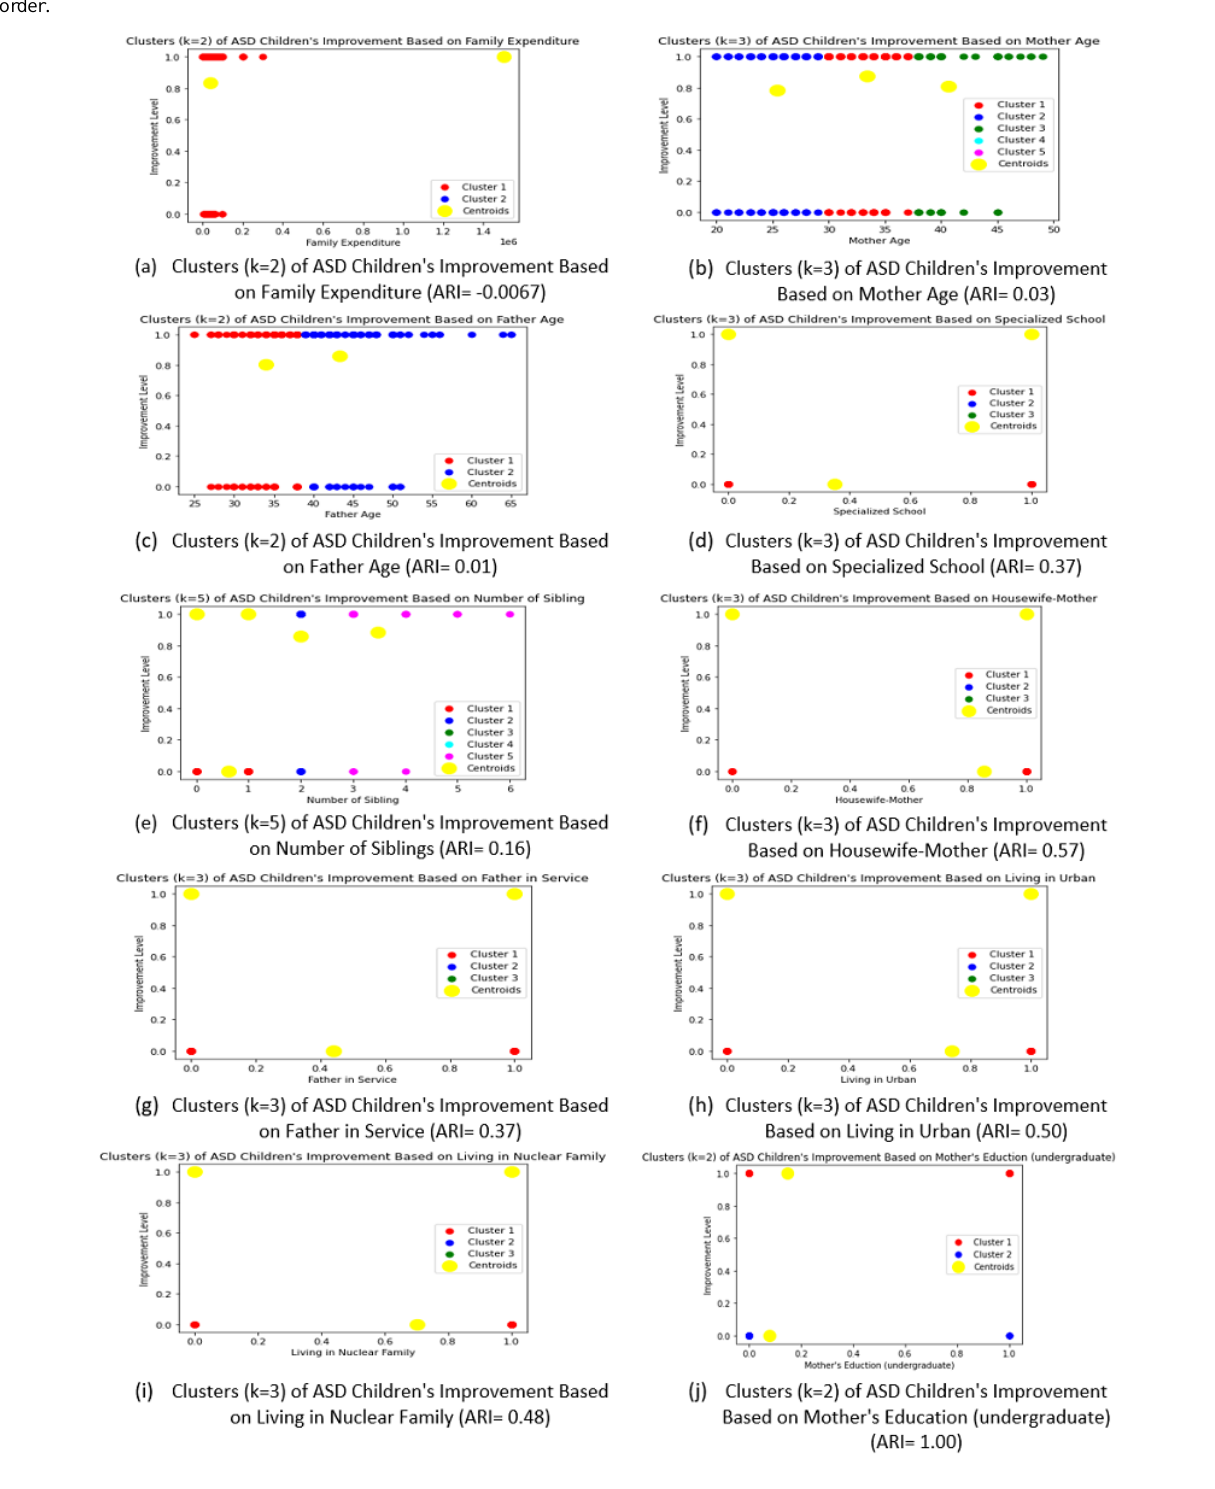
Figure 2. Cluster for the Selected Features of “Daily Living Skills” using K-Means Algorithm. ARI: Adjusted Random Index; ASD: Autism spectrum